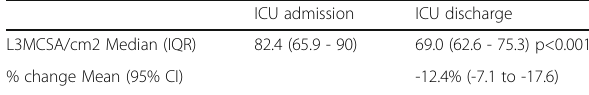
Table 80 (abstract A250). Acute muscle